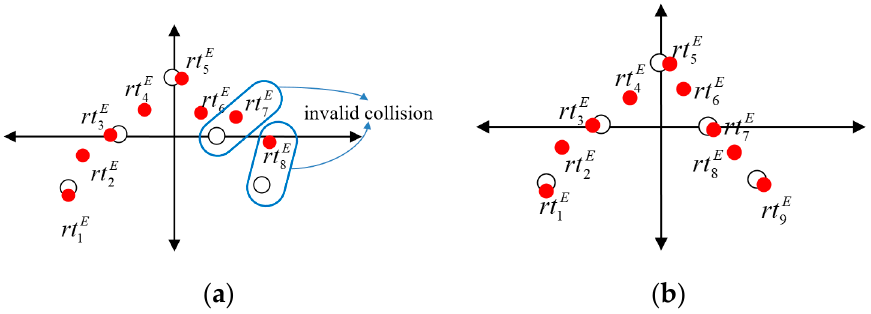
Figure 7. The diagram of eigenvalue detection. ( a ) invalid collisions and ( b ) successful collisions.